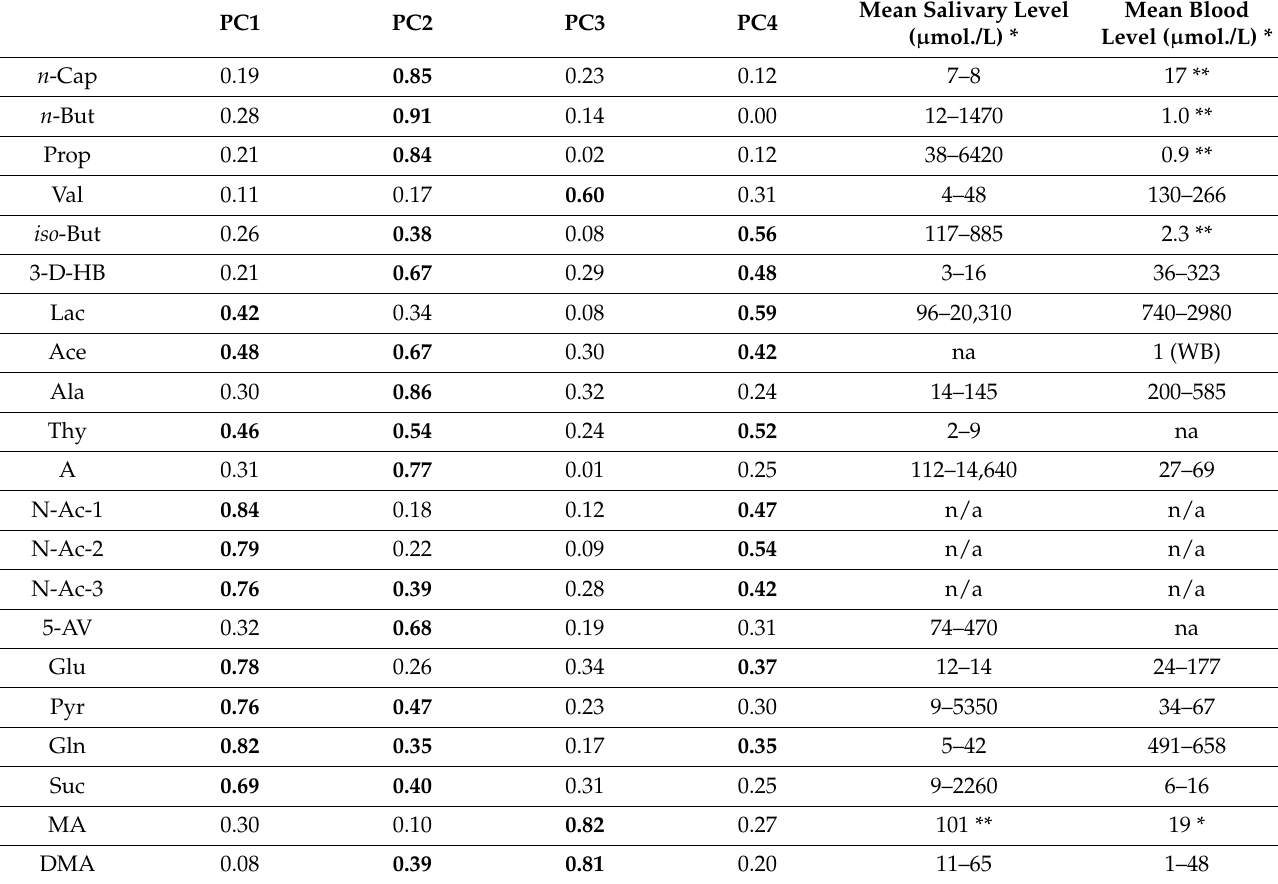
Table 5. Loading vectors of salivary metabolites on (i.e., linear correlations with) components (PCs) 1–4 for a factor analysis model performed with a total of 31 1 H NMR-determined analytes. The TSP-normalized dataset was glog-transformed and Pareto-scaled prior to principal factor anal- ysis, and Varimax rotation with Kaiser normalization was then applied for the purpose of further analysis. The significance threshold of component (PC) loadings vectors was set at 0.35 in view of the large sample size of this investigation. Abbreviations: as Figure 10, with na, not available; n/a, not applicable. * Values obtained from the HMDB [47]; ** only one observation